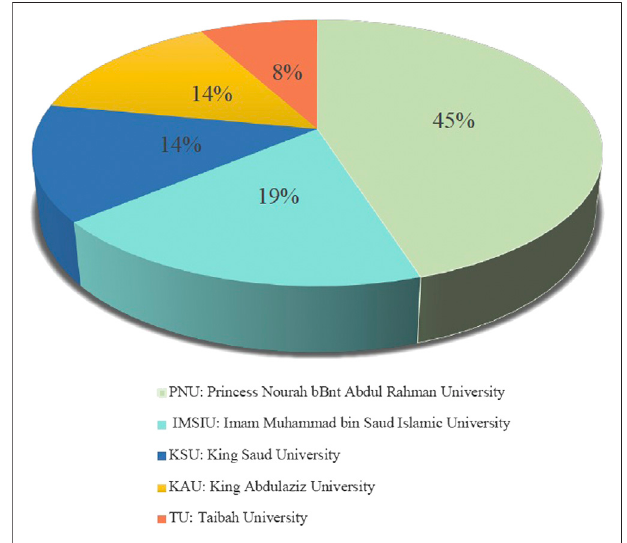
FIGURE 1 | Distribution of respondents across Saudi Arabia University.